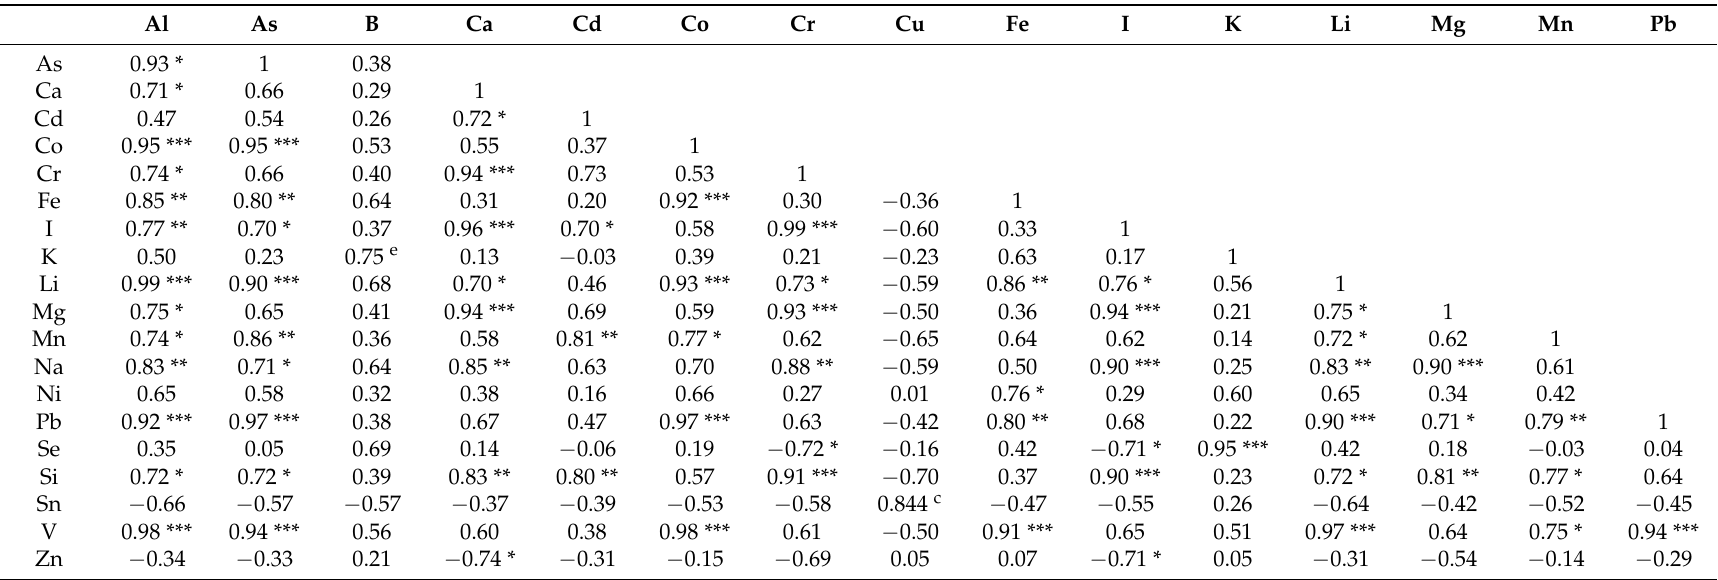
Table 6. Correlation coefficients between mineral elements in